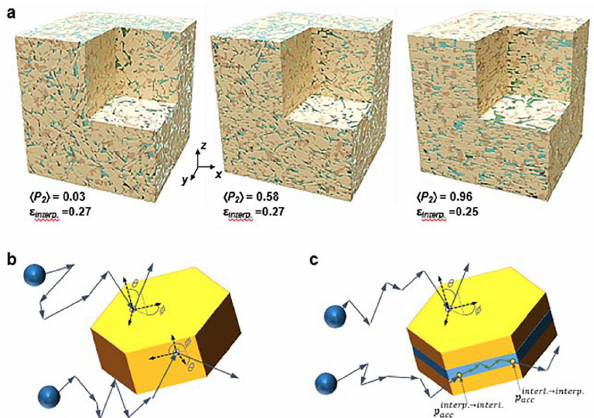
Fig. 3. (a) Development of synthetic porous media with simi- lar interparticle porosity but different degree of anisotropy for particle orientation described by order parameter (i.e., (cid:104) P 2 (cid:105) order parameter). Illustration of Brownian dynamics charac- teristic to water in a Na-kaolinite (b) and Na-vermiculite (c). In contrast to interlayer, free kaolinite transport in vermiculite takes place in the intra-particle space and the interlayer (mod- ified after Asaad et al.